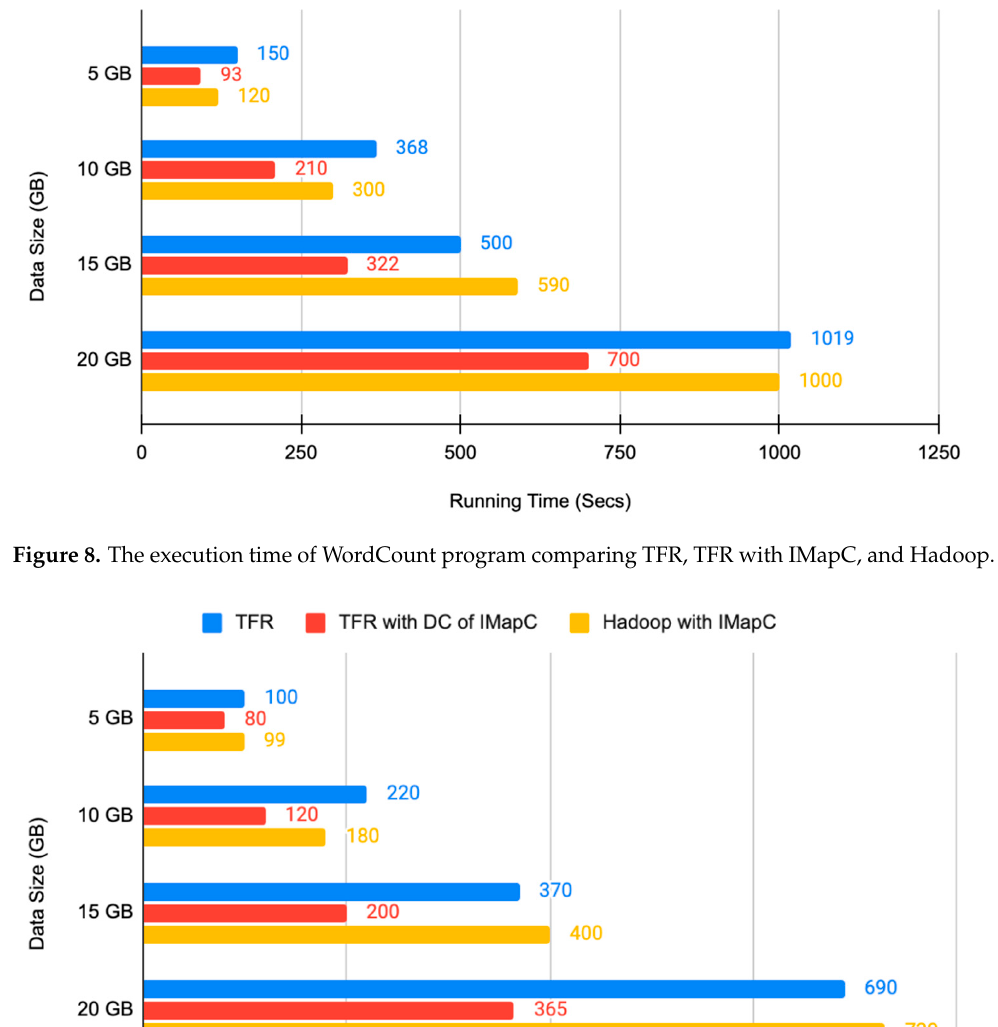
Figure 7. The execution time of the Sort program for Inner Mapping Combiner (IMapC) Over De- fault Combiner and without Combiner in TFR.